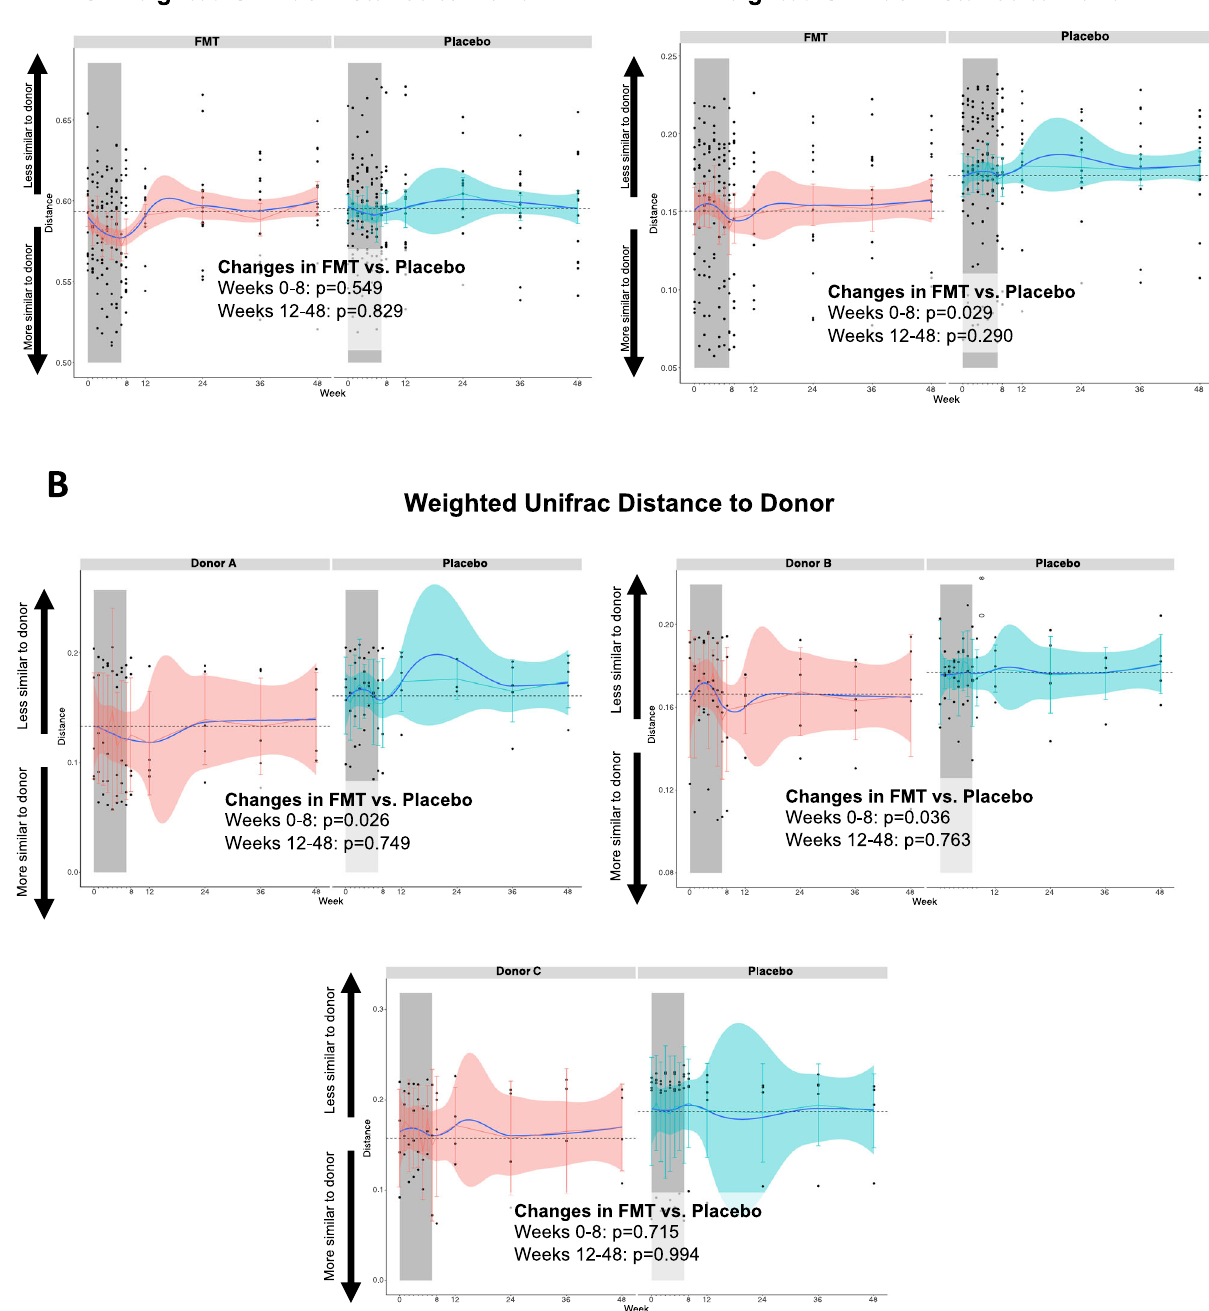
Fig. 2 Engraftment of donor ’ s microbiota on study participants. Unifrac distances from recipients in the FMT (red) and placebo (blue) groups to donors. Panel A represents the unweighted and weighted Unifrac trajectories in the FMT and the placebo group. The peak effect occurred at week 3 for unweighted Unifrac, which considers the presence or absence of taxa, and at week 8 for weighted Unifrac, which considers their abundance. To explore donor-effects, in panel B we segregated the subjects in the FMT group per donor. The effect on weighted Unifrac distances were more pronounced for donor A. The Unifrac distances in the placebo group were calculated from each sample to the assigned donor, in order to understand the similarities with donors explained by randomness. Black dots represent individual measurements. Blue lines represent the smoothed mean value. Horizontal dashed lines represent the baseline levels. Vertical bars represent the 95% con fi dence intervals. The gray area indicates the induction period in which study participants received FMT or placebo. Two-sided P values estimated using mixed models not adjusted for multiple comparisons remained unchanged after adjustment for nadir CD4 and time since HIV diagnosis. Abbreviatures: FMT, fecal microbiota transplant. n = 361 biologically independent samples from 14 individuals in the FMT group and 15 individuals in the placebo